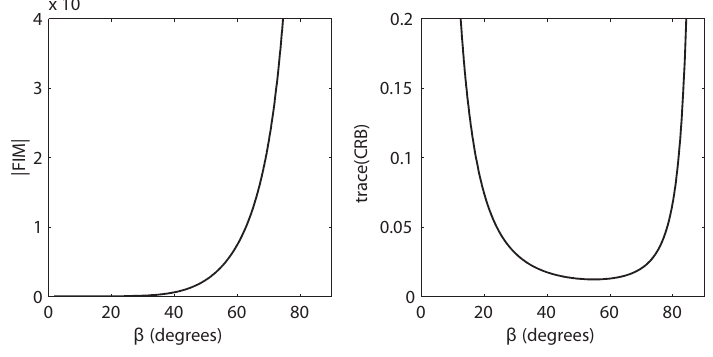
Figure 3. Fisher Information Matrix (FIM) determinant versus Cramer-Rao Bound for β between zero and π/ 2 , considering a circular formation centered at the target projection on the surface